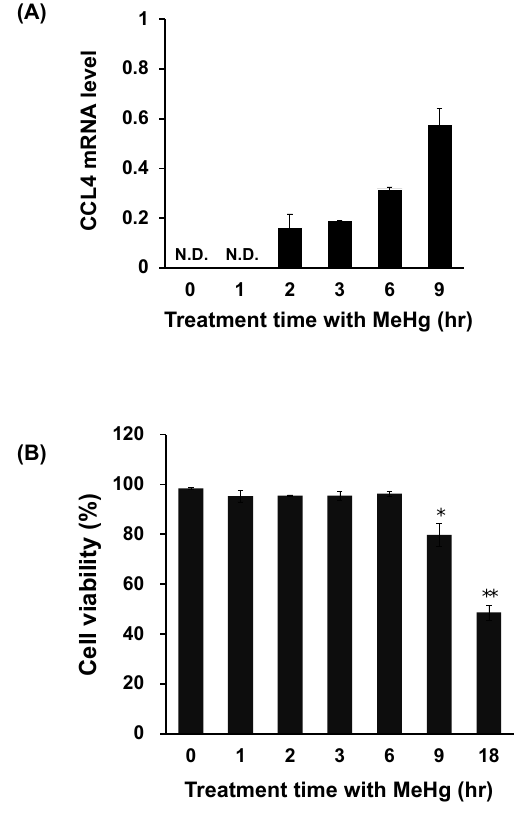
Figure 3. Relationship between cell viability and CCL4 expression in methylmercury-treated mouse C17.2 neural stem cells. C17.2 cells (4 × 10 5 cells/2 mL) were seeded into 6-well plates. After incubation